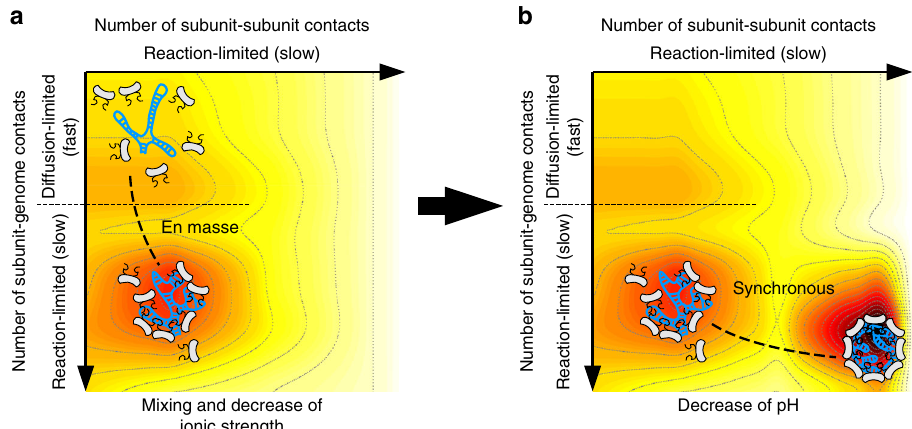
Fig. 5 Schematical representations of the free energy landscape in varying ionic conditions. Dark colors stand for low free energies, while bright colors represent high free energies. a This graph illustrates the mixing of subunits with genome and a change of ionic strength at neutral pH, which leads to the formation of NPCs through an en masse pathway. b This graph illustrates the subsequent relaxation of metastable NPCs into virions upon a change of pH through a